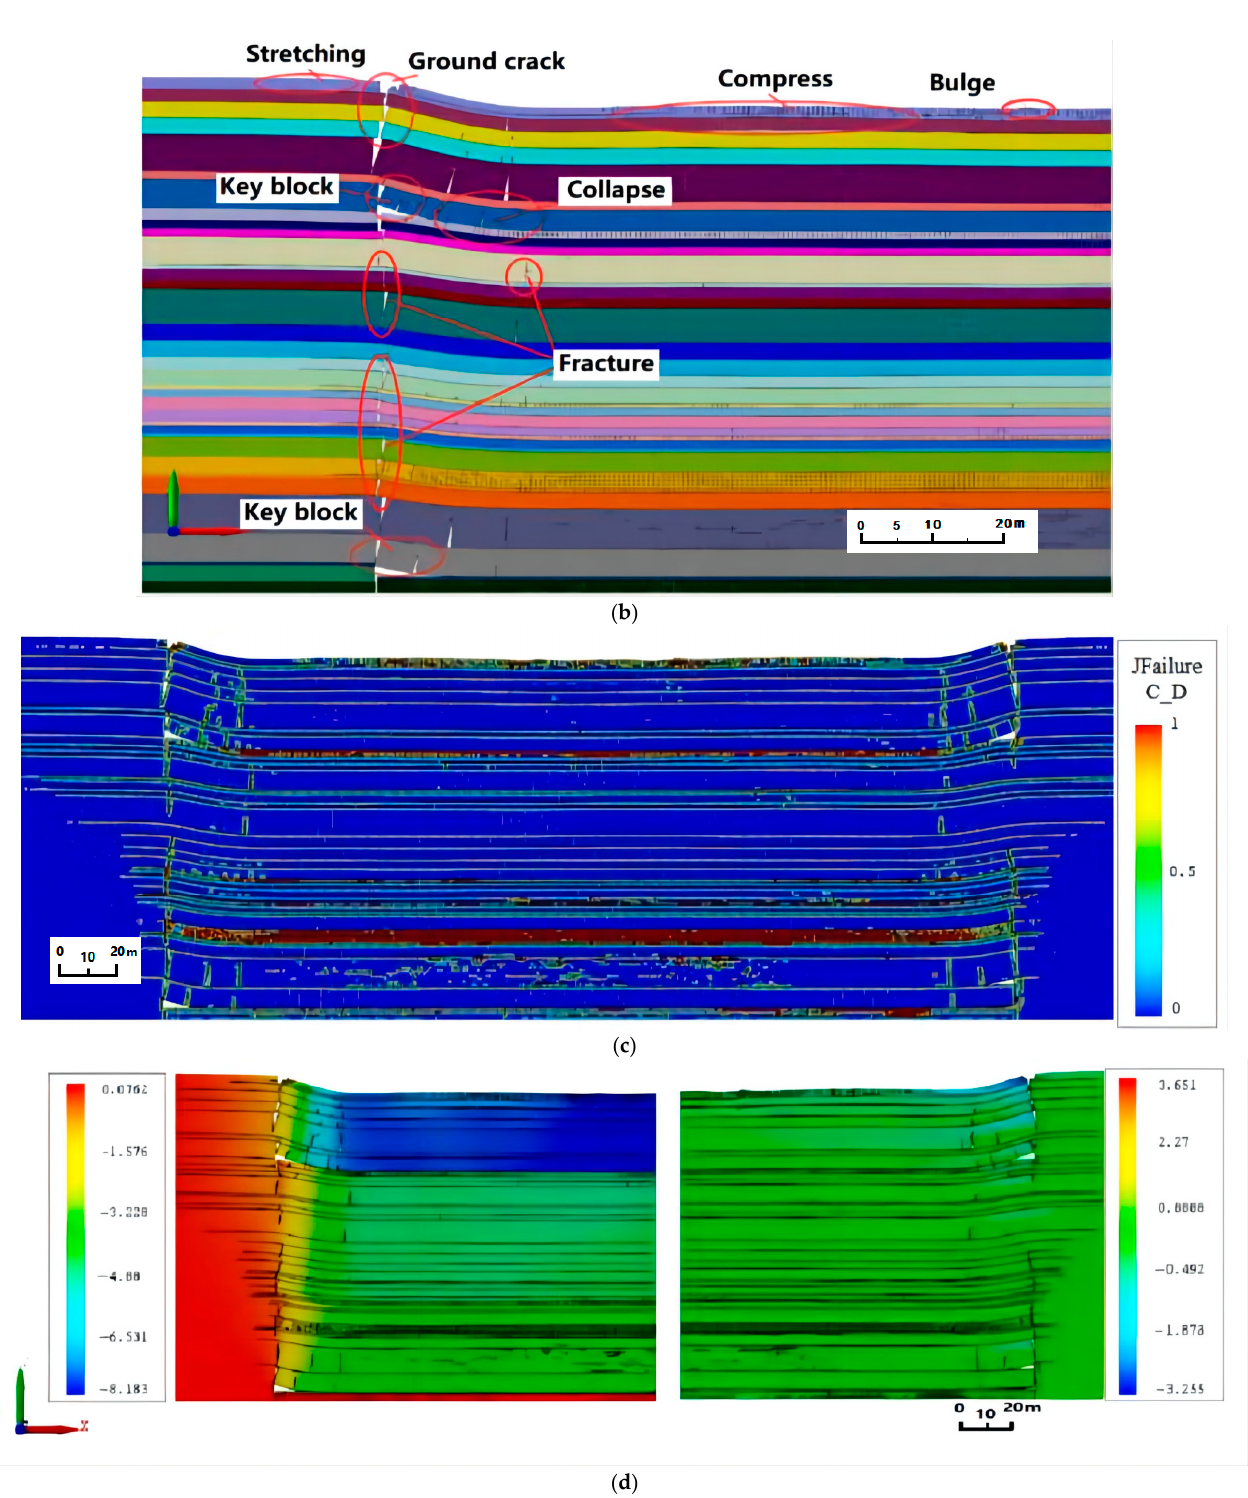
Figure 5. Characteristics of bedrock and surface damage. ( a ) Bedrock failure in upper coal seam mining; ( b ) Bedrock failure of all coal mining; ( c ) Cloud map of stress distribution of bedrock; ( d ) Cloud map of bedrock settlement (left is vertical, right is horizontal).